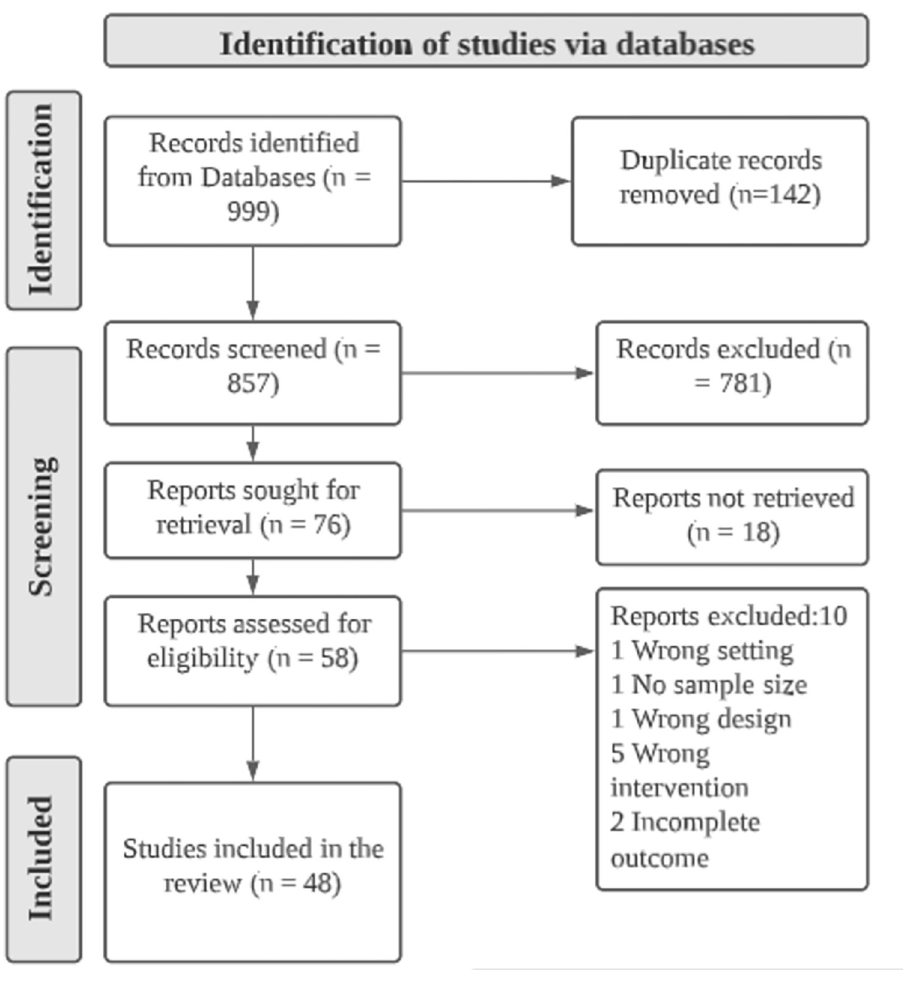
Fig 1. PRISMA flow